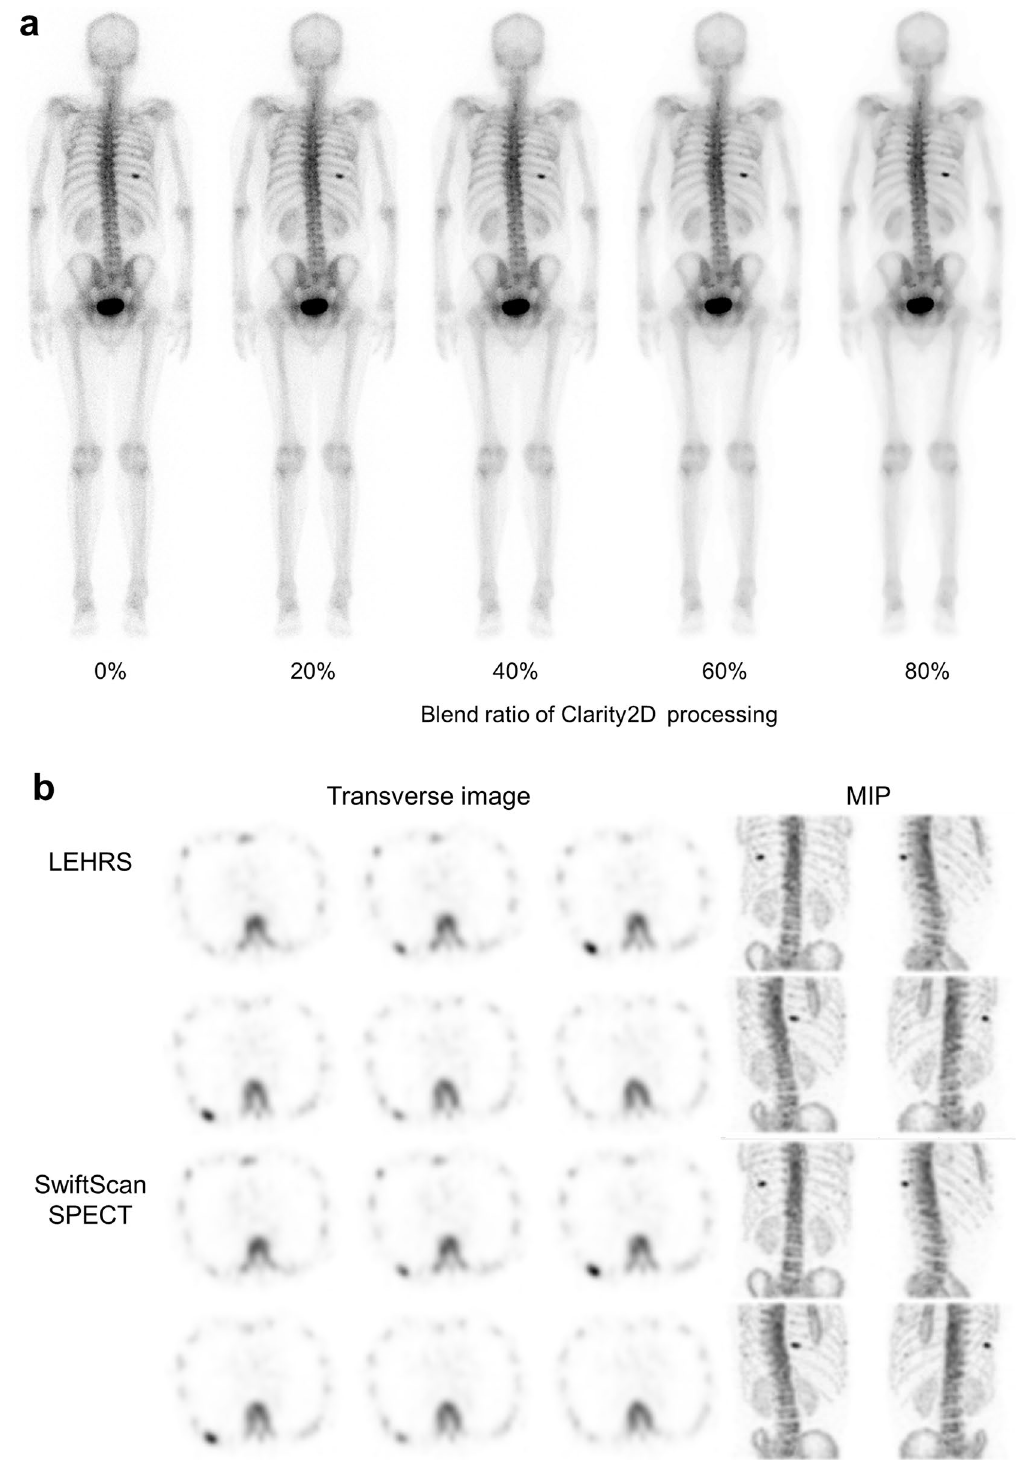
Figure 6. Clinical image of SwiftScan planar and SPECT images. ( a ) Shows a whole-body (WB) image with and without SwiftScan planar processing. The blend ratio of Clarity 2D processing 0% means the WB image without SwiftScan planar processing. ( b ) Shows transverse and maximum intensity projection (MIP) images with and without SwiftScan SPECT. The first and second rows show the images of low-energy high-resolution and sensitivity (LEHRS) collimator without SwiftScan SPECT. The third and fourth rows show the SwiftScan SPECT